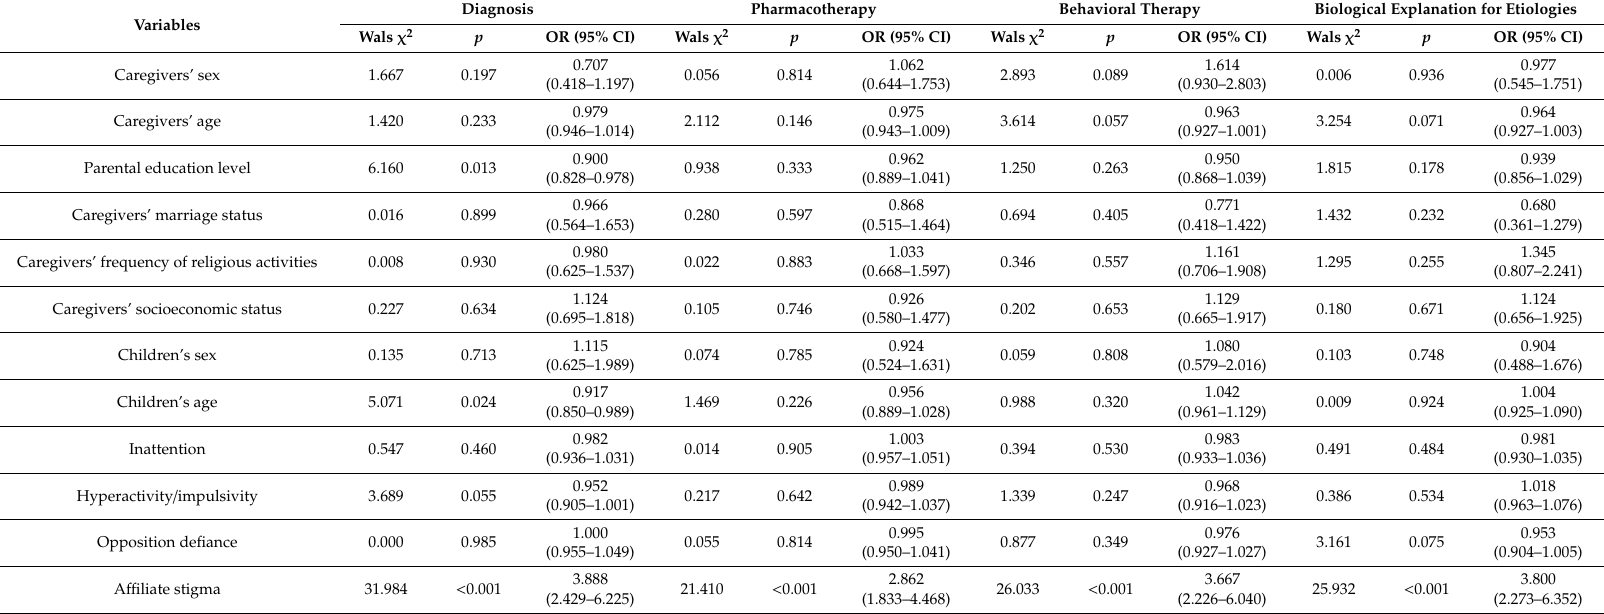
Table 3. Associations of sociodemographic variables and a ffi liate stigma with caregivers’ unfavorable attitude toward children’s ADHD.